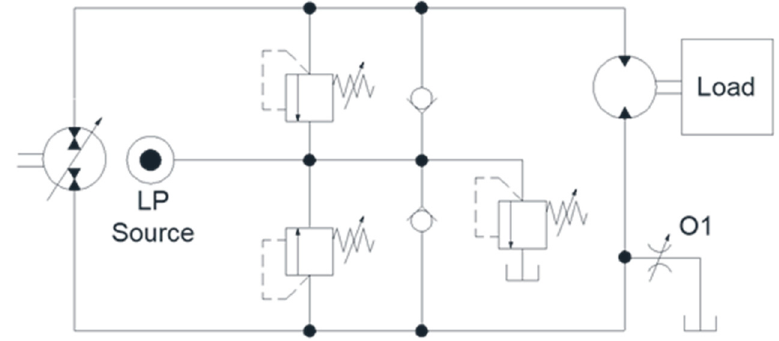
Figure 6. Generic hydrostatic transmission for efficiency comparison.